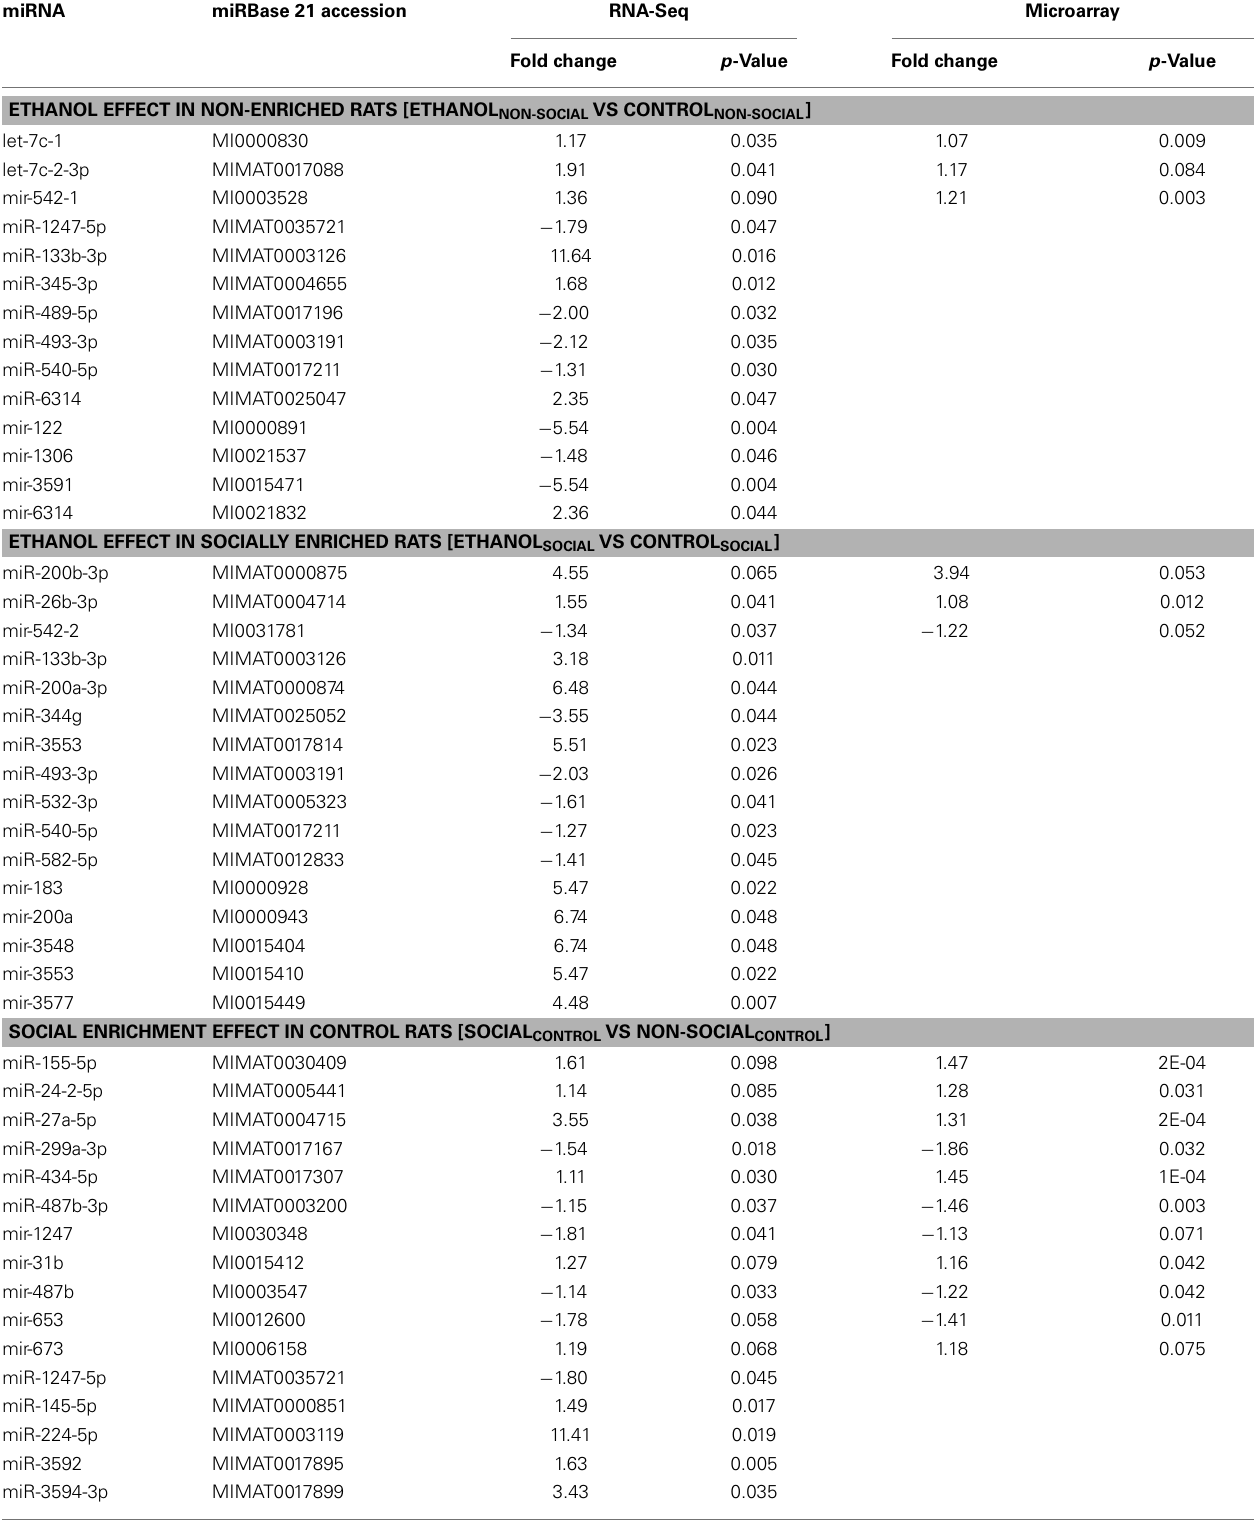
Table 2 | Nominally significant miRNAs in ventral striatum